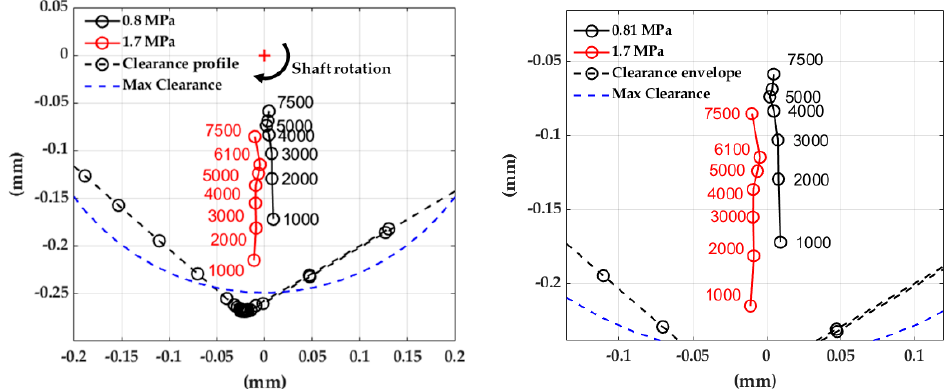
Figure 13. Direct Lube Rocker Pivot bearing shaft centerline with detail on the right.